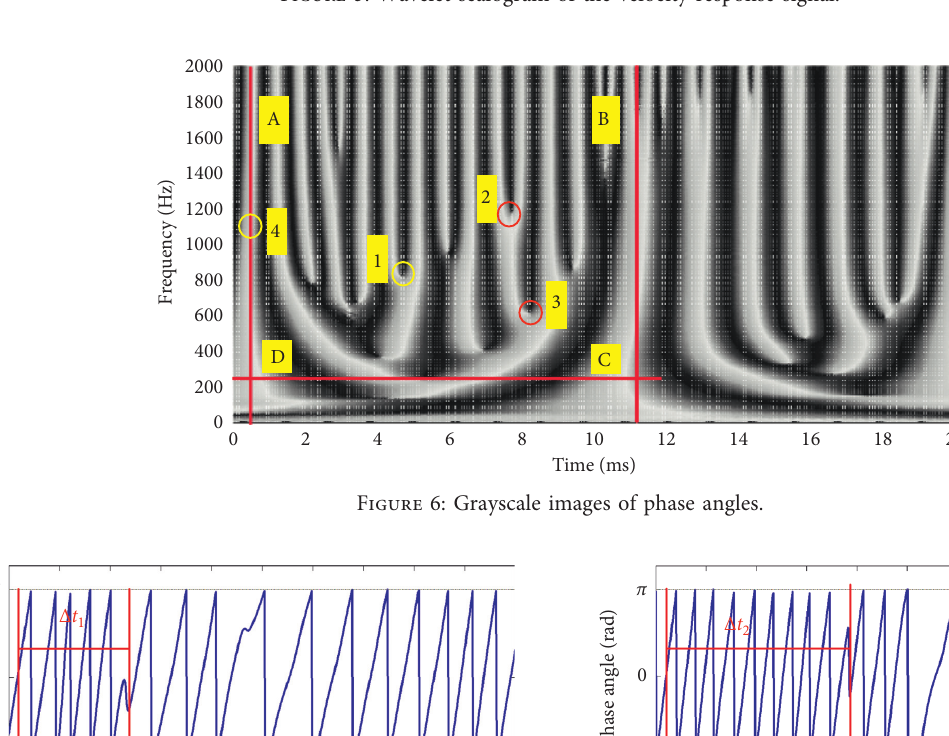
Figure 5: Wavelet scalogram of the velocity response signal.